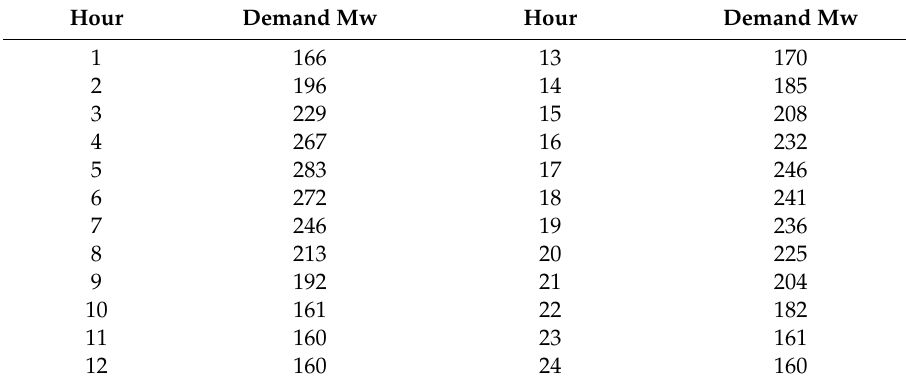
Table A4. Hourly demand for 24 h.